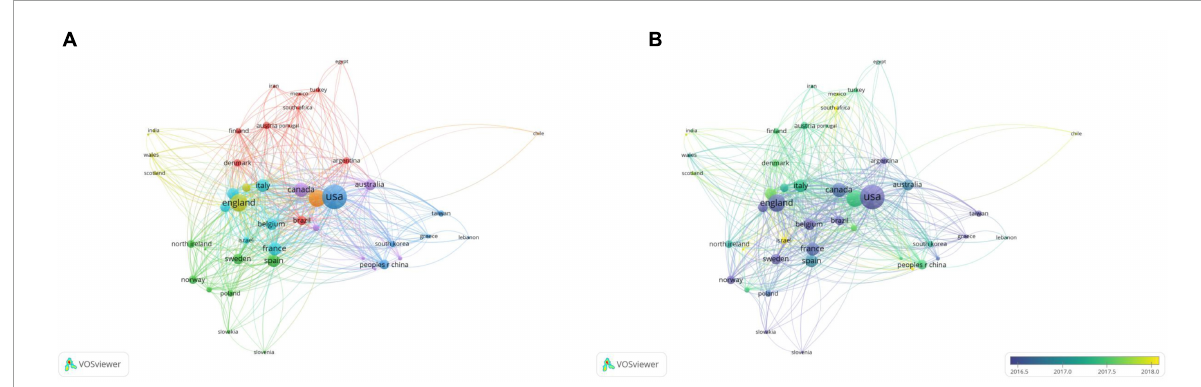
FIGURE6 The bibliometric analysis of the co-authorship of countries/regions in the field of PCa bone metastasis. (A) The network visualization map of countries/regions collaborations in the field of PCa bone metastasis. (B) The overlay visualization map of countries/regions collaborations in the field of PCa bone